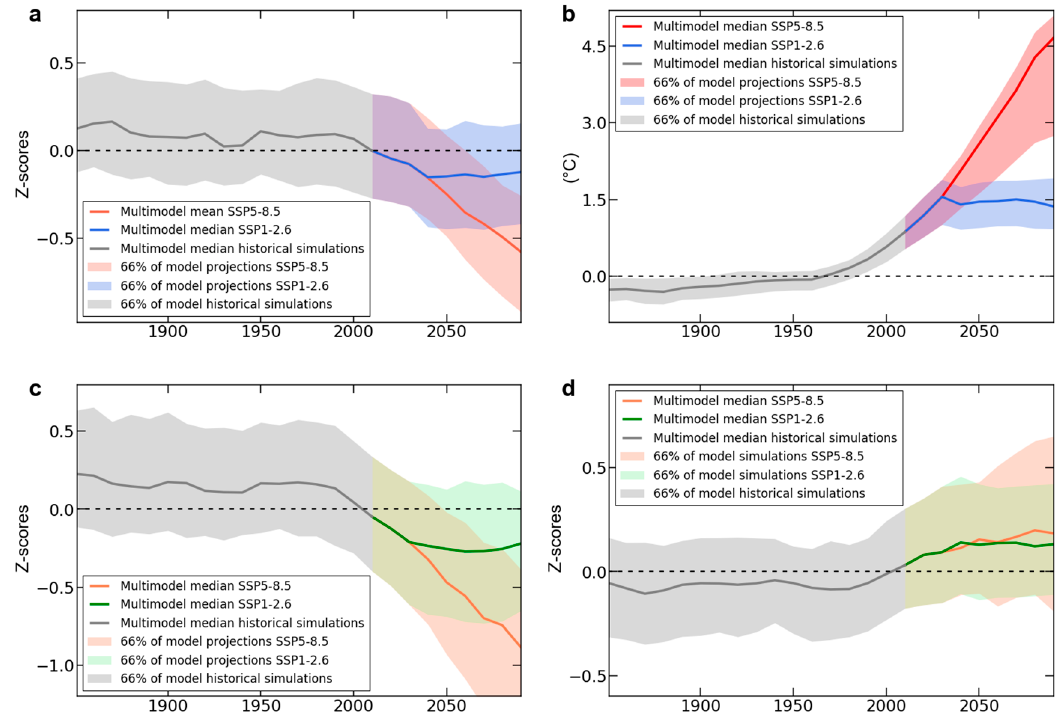
Figure 8. CMIP6’s median intermodel spread and median of ( a ) precipitation, ( b ) surface temperature, ( c ) surface soil moisture (soil’s top 10 cm), and ( d ) water evaporation flux. The colored shaded areas represent the interquartile range of the models’ projections (bounded by the 17th and 83rd percentiles), while the solid lines represent the multimodel median for historical simulations (1850–2015), and SSP1-2.6 and SSP5-8.5 (2015–2100). All time series were smoothed using moving mean of 10 years.